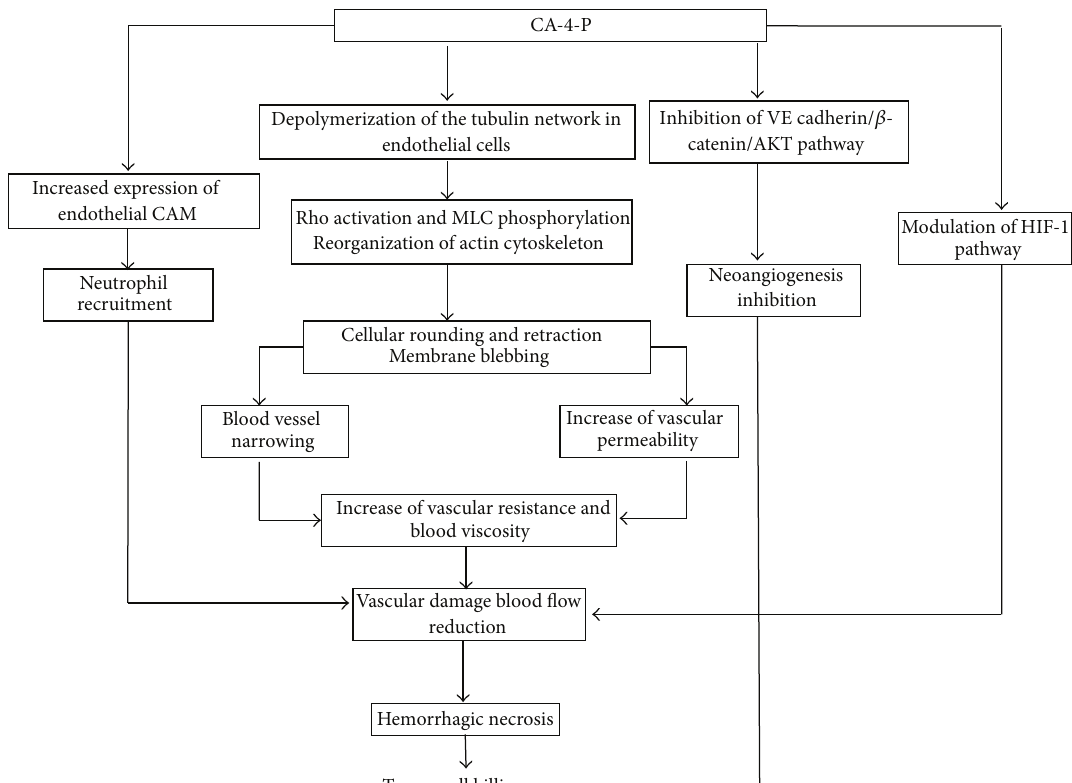
Figure 4: Combretastatin A-4-P: mechanisms of action at tumor